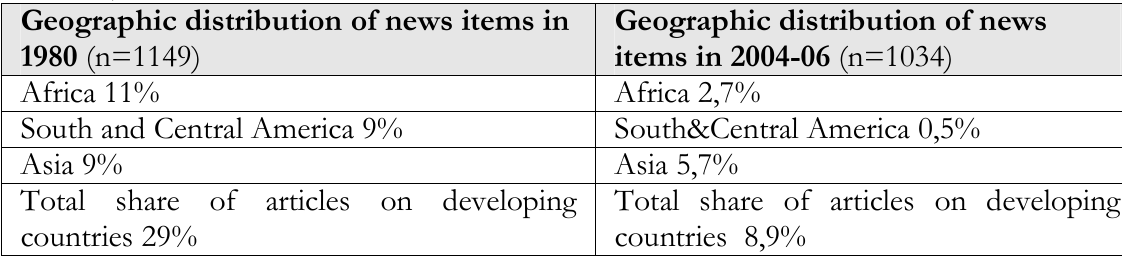
Table 1: Delo's shift of international news coverage of developing countries by